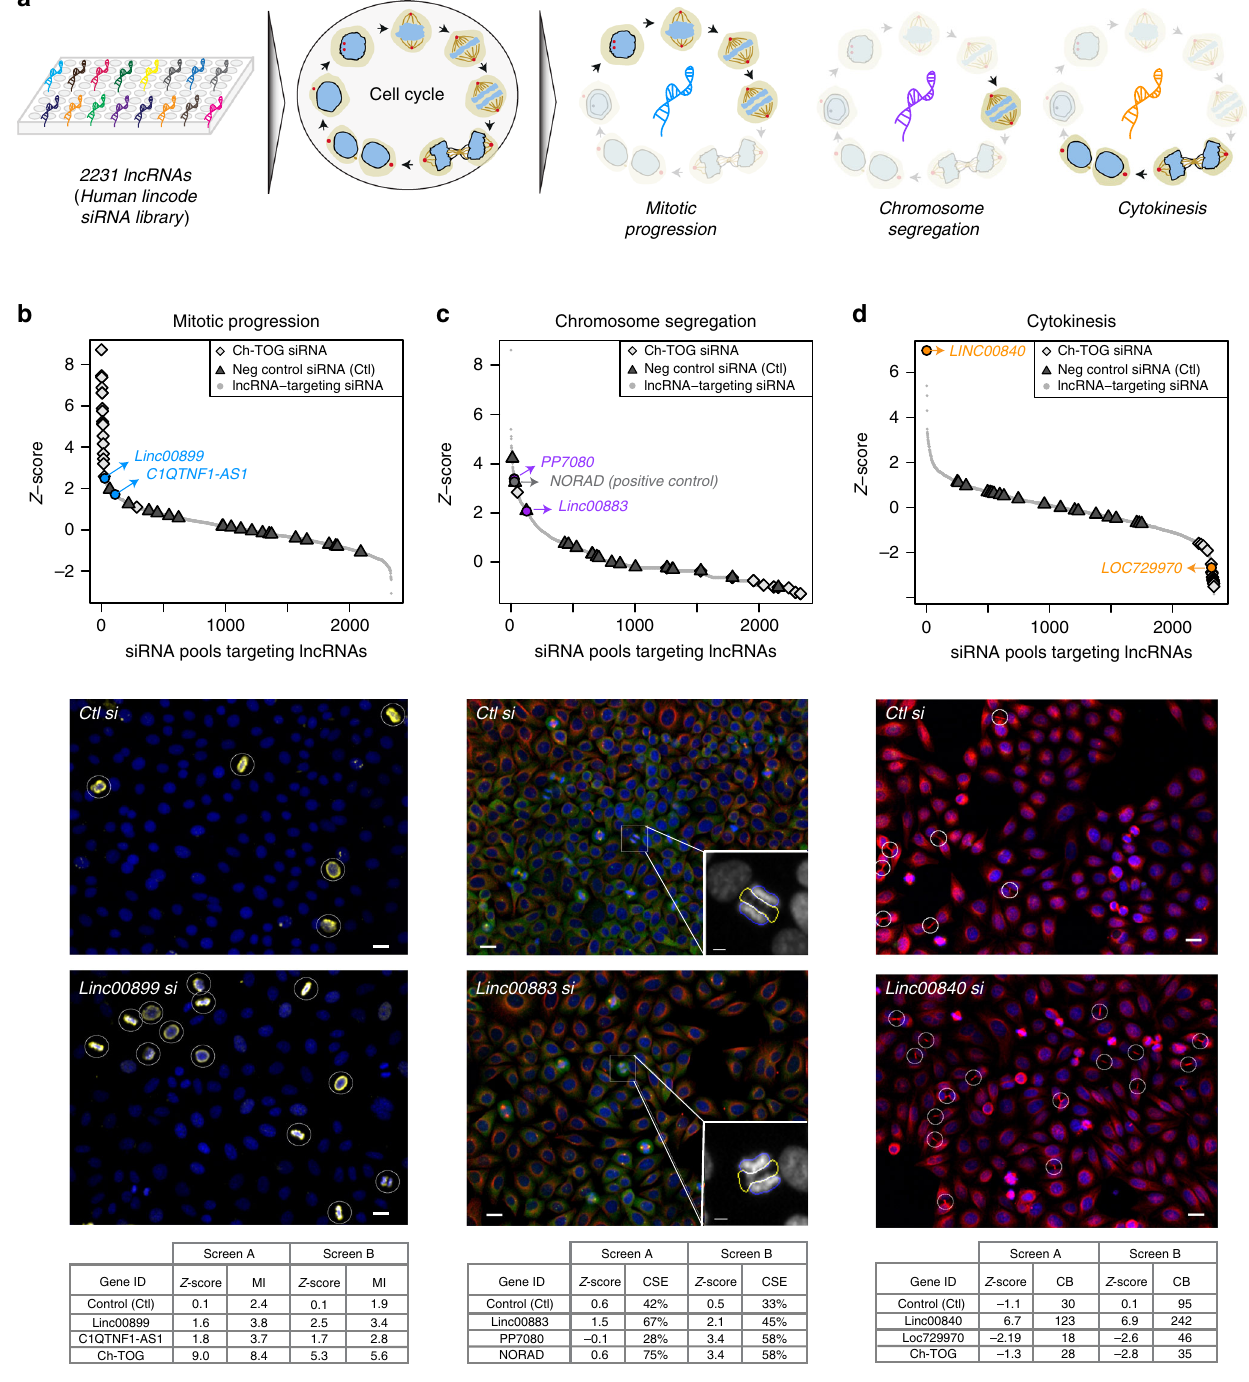
cytokinesis category, and found that knockdown of linc00840 cytokinesis. Overall, our screen identi fi ed functions of lncRNAs in the control of cell division, supporting the idea that lncRNAs play an important role in cell cycle progression. Molecular characterisation of linc00899 and C1QTNF1-AS1 . Two lncRNAs associated with delayed mitotic